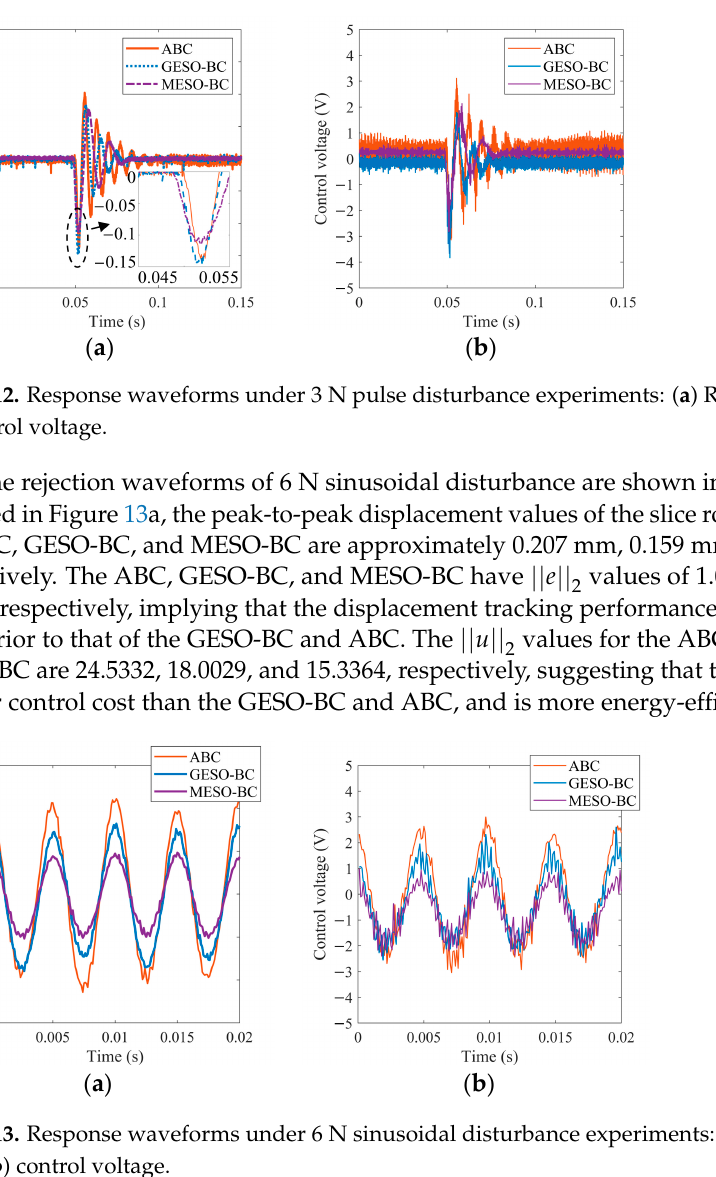
( c ) Figure 14. Rotor displacement from standstill to 12,000 rpm (200 Hz) accelerated rotation experi- ments: ( a ) ABC; ( b ) GESO-BC; ( c ) MESO-BC. According to the above experimental results, the ESO has the capability of estimat- ing the lumped disturbance of the AMB system and compensating for it in the control process. Furthermore, the MESO has smaller observation errors and faster convergence of observation errors than the GESO for the same bandwidth. The reason is that the ME- SO incorporated known model information into its design. Therefore, the MESO-BC provided better control performance.